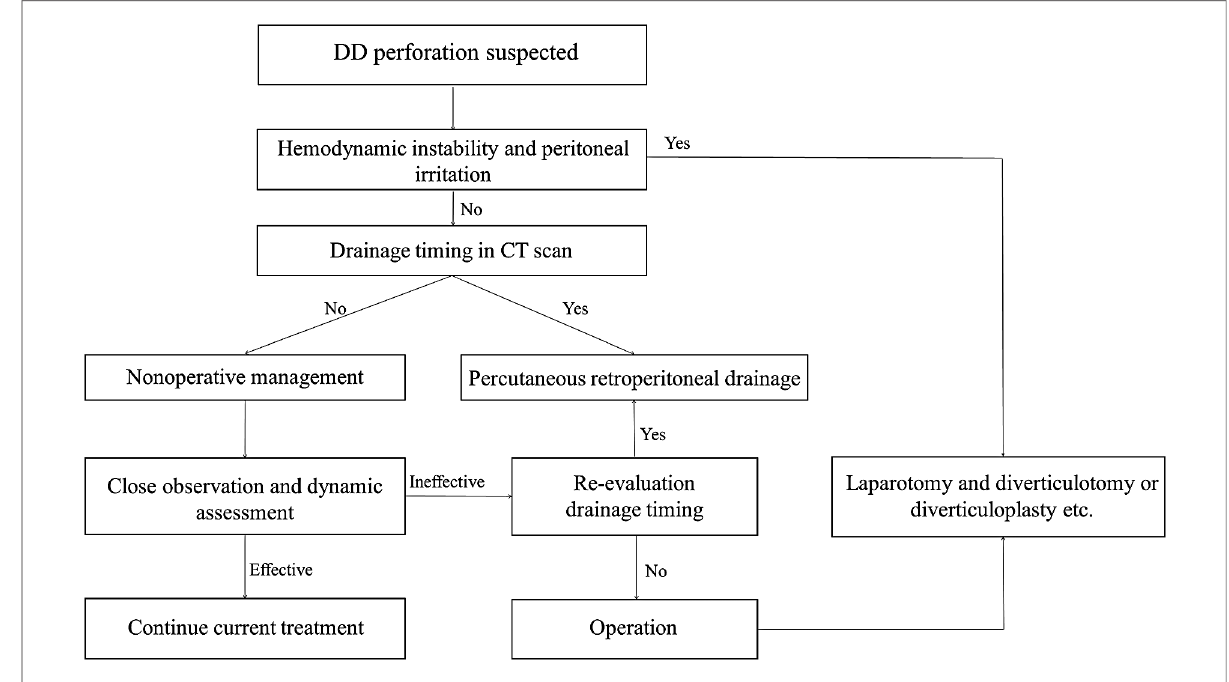
FIGURE 4 Flow diagram of step-up treatment model for